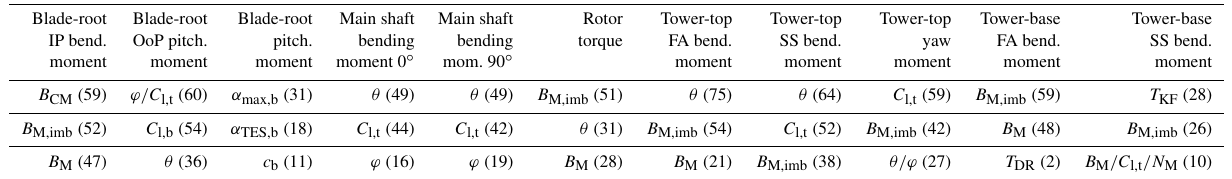
Tower-top Tower-base Tower-base